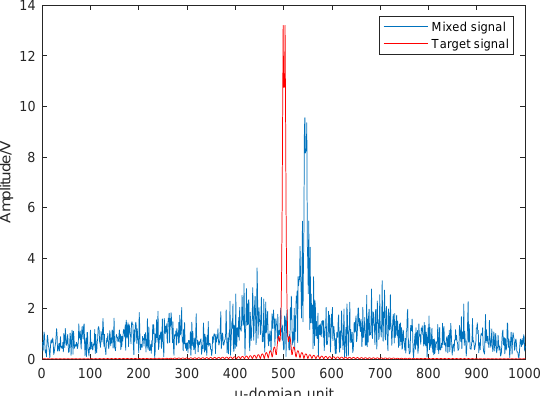
Figure 17. The u -domain waveform of the signal after jamming suppressed and the transmitting LFM signal at α µ when there is a Doppler